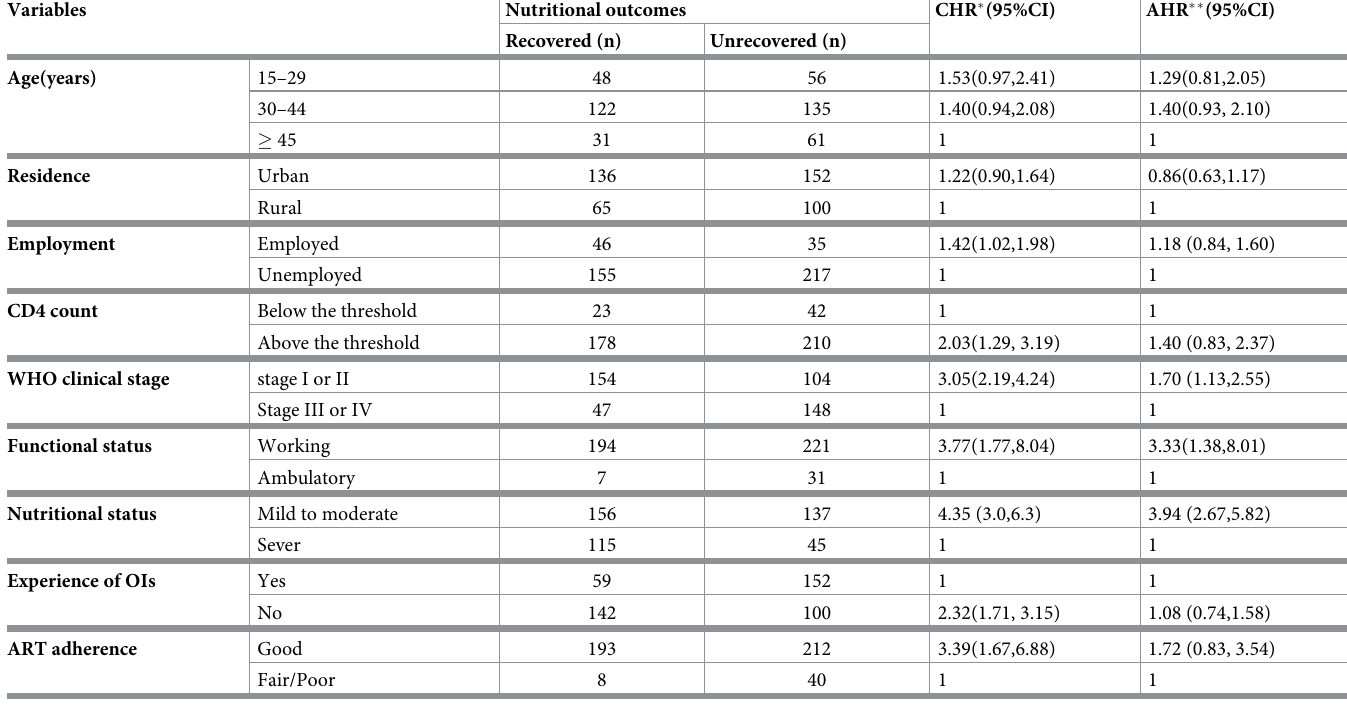
Table 6. Bivariable and multivariable Cox regression of predictors for recovery rate among adults with HIV/AIDS treated with RTUF at Debre Markos Referral Hospital from July 1 st , 2015 to December 31 st ,